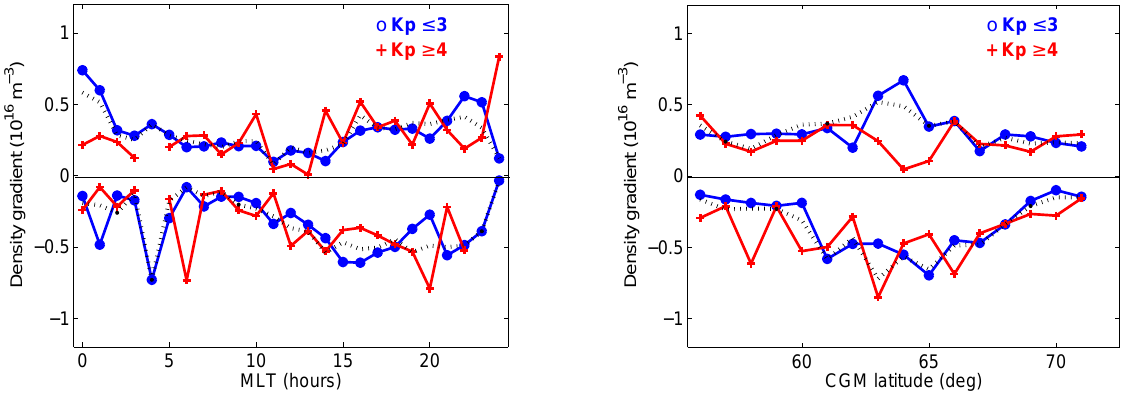
Fig. 6. The diurnal (left) and latitudinal (right) variation of the electron density gradient at the edges of the trough. Positive values refer to the poleward and negative values to the equatorward edge. The heavy dotted lines indicate the mean value of all observations and the red and blue ones the mean values from times of Kp > 4 and Kp < 3 , respectively.